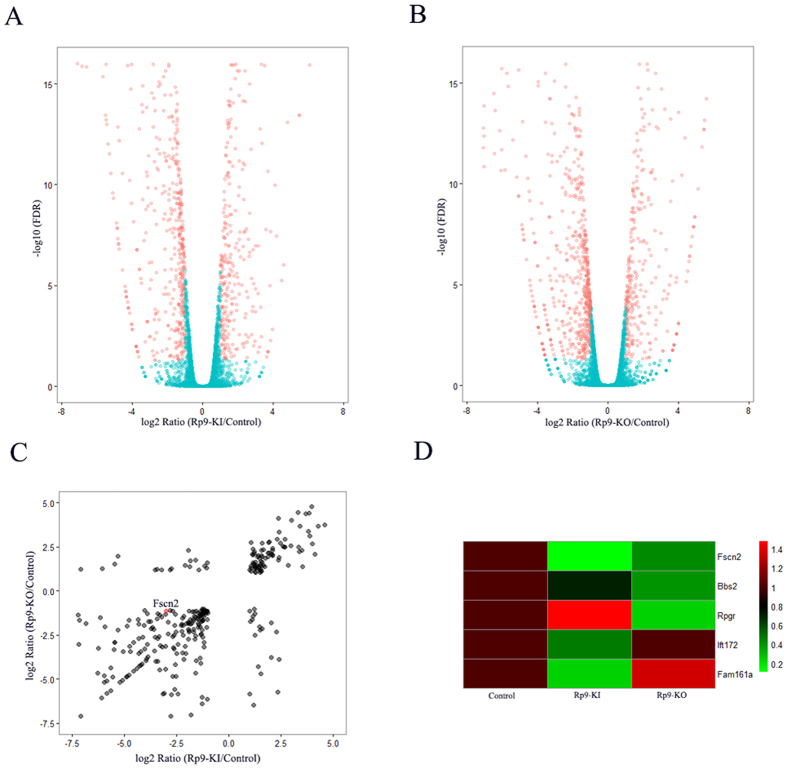
RNA-seq analyses detected gene expression changes in Rp9 mutant cells.(A) Volcano plot showing genes differentially expressed in Rp9-KI compared with control group. Red dots show the 784 genes with a |log2FC| > 1 and FDR < 0.05. (B) Volcano plot showing genes differentially expressed in Rp9-KO compared with control group. Red dots show the 934 genes with a |log2FC| > 1 and FDR < 0.05. (C) Overlap of differential gene expression betweenRp9-KI and Rp9-KO group. Red dots show the Fscn2 gene down-regulated in both groups. (D) Heatmaps present RP associated gene expression in Rp9-KI and Rp9-KO group.